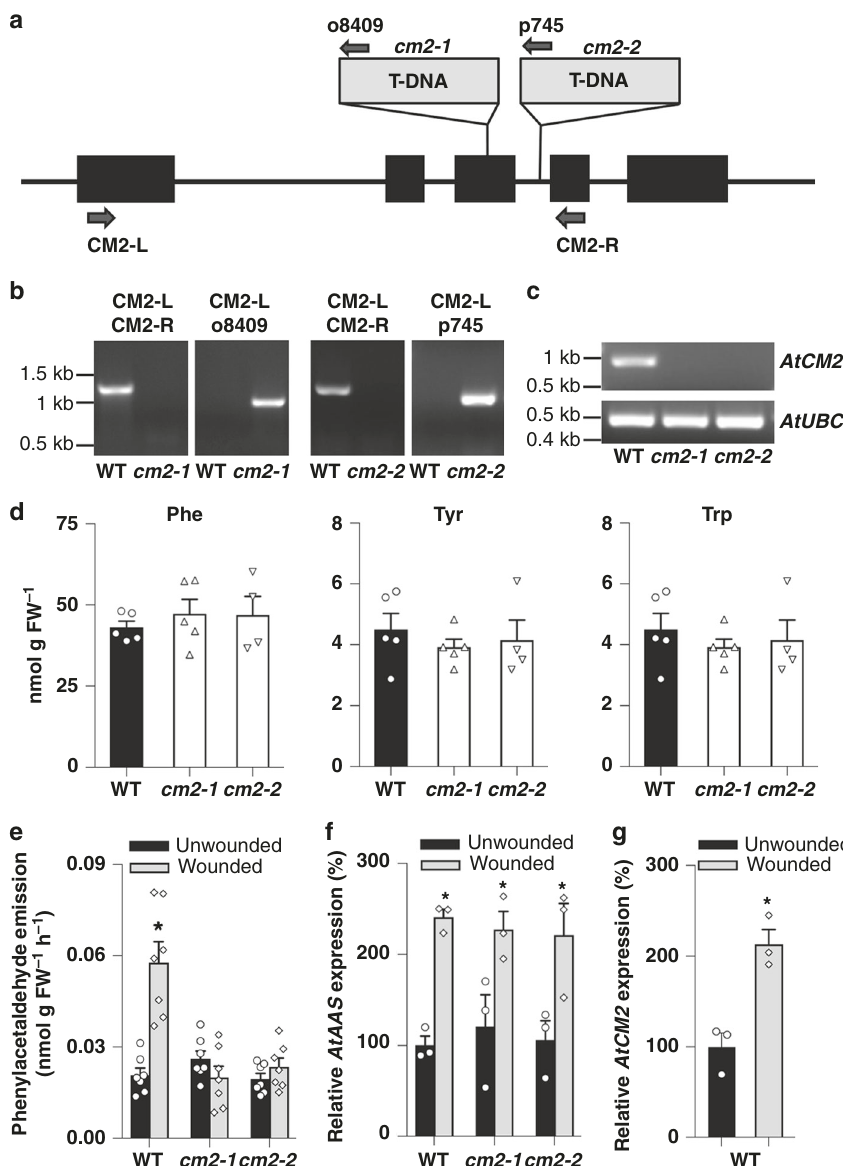
Fig. 4 Characterization of the Arabidopsis cm2 mutants. a Structure of the AtCM2 gene showing the T-DNA insertion sites in cm2-1 and cm2-2 mutant lines. Black boxes represent exons. Arrows indicate the positions of primers used for analysis. b Genotyping of the Arabidopsis cm2 mutants by PCR analysis using primers speci fi c to genomic regions fl anking each T-DNA as well as T-DNA-speci fi c primers. c RT-PCR analysis of AtCM2 transcripts in wild-type (ecotype Col-0) and the cm2 mutants. Transcript levels of AtUBC encoding ubiquitin-conjugating enzyme were used as endogenous control. d Aromatic amino acid levels in leaves of Arabidopsis wild-type (ecotype Col-0; black bars) and cm2 mutants (white bars). Data are means ± SE (n ≥ 3 biological replicates). e Phenylacetaldehyde emission from leaves of Arabidopsis wild-type and cm2 mutants upon mechanical wounding. Volatiles were collected from intact (black bars) and wounded (gray bars) leaves for 24 h and analyzed by GC-MS. Data are means± SE ( n ≥ 7 biological replicates). * P < 0.05 as determined by paired two-tailed Student ’ s t -test. f AtAAS transcript levels in Arabidopsis leaves of wild-type and cm2 mutants upon mechanical wounding, as determined by qRT-PCR. g AtCM2 transcript levels in wild-type Arabidopsis leaves upon mechanical wounding, as determined by qRT-PCR. In ( f , g ) data are presented as relative to untreated wild-type control plants set as 100%, and bar colors are same as in ( e ). Data are means ± SE ( n = 3 biological replicates). * P < 0.05 as determined by paired two-tailed Student ’ s t Plant-CARE program 44 29 bp upstream from this TSS2. The shorter PhADT3 transcript, designated as PhADT3S , encodes PhADT3S isoform containing intact ADT/PDT catalytic and ACT regulatory domains, but lacking a plastid-targeting peptide (Supplementary Figure 13a).